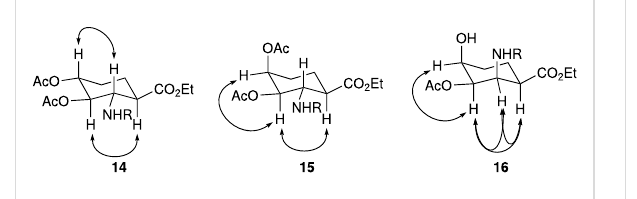
Figure 3: Selected NOESY correlations for 24 – 26